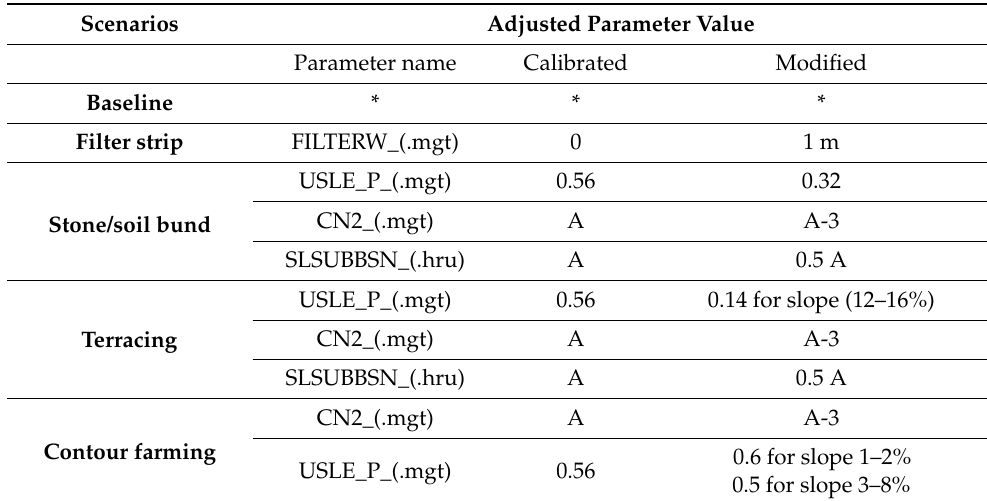
Table 4. Description of the selected BMPs and the parameters changes in the SWAT